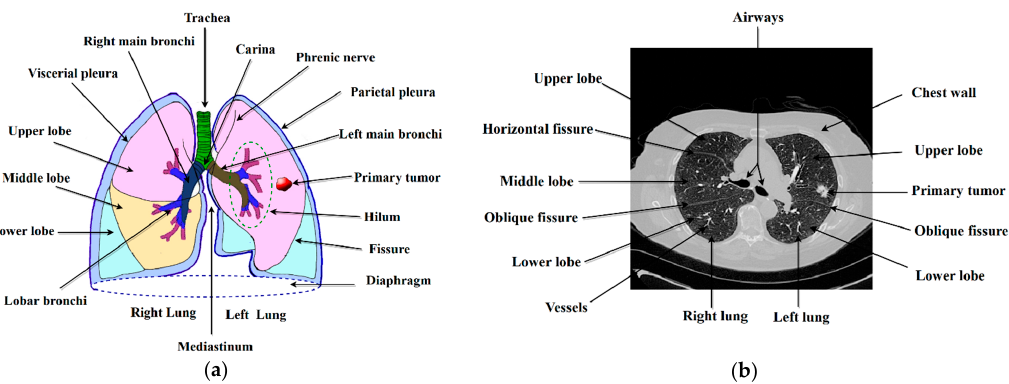
Figure 2. Anatomical structure of the human lungs: ( a ) schematic diagram of lung structures; ( b ) lung structures on the CT scan.